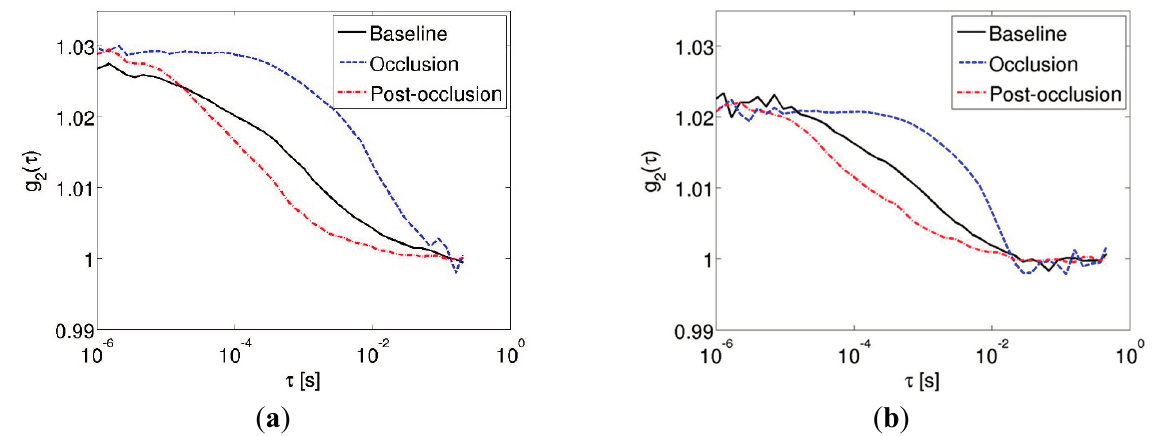
Figure 4. Autocorrelation traces in the cuff occlusion experiments (solid black line—at baseline; dashed blue line—during cuff occlusion; dashed-dotted red line—immediately post-occlusion) acquired using the ( a ) Hardware correlator; ( b ) The Raspberry Pi.